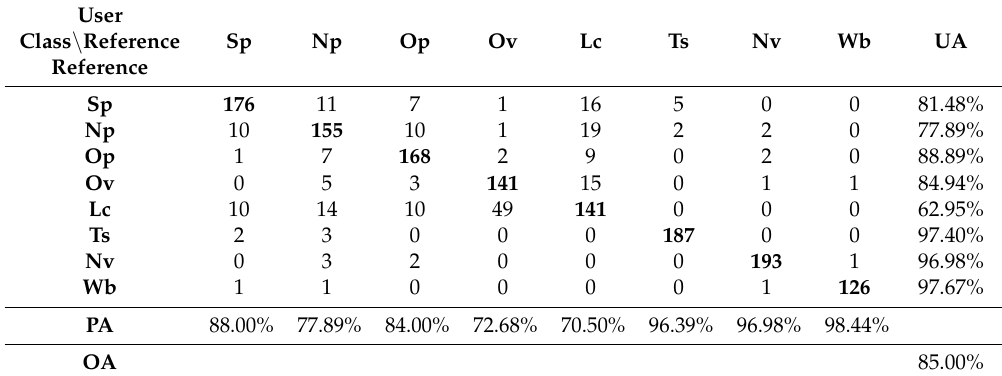
Table 3. Confusion matrices between classified image and reference data for the eight most important features.